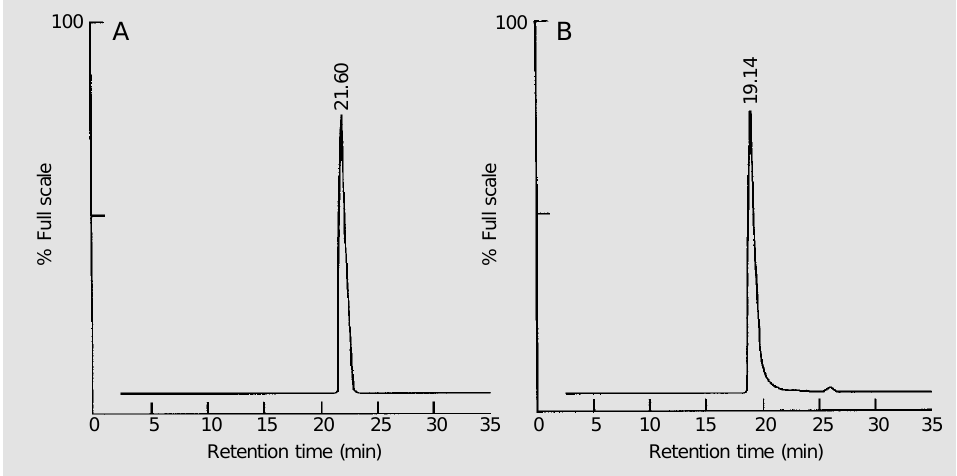
Figure 2. High-perfomance